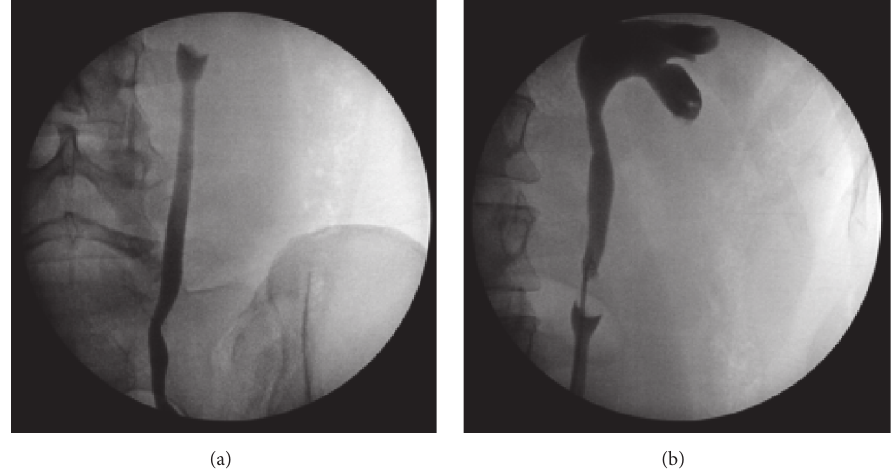
Figure 1: Images from the retrograde pyelogram performed during the initial ureteroscopy and resection. Note that no contrast is passing above the mass (a) and the filling defect from the mass (b) once the ureteric catheter is passed around it.